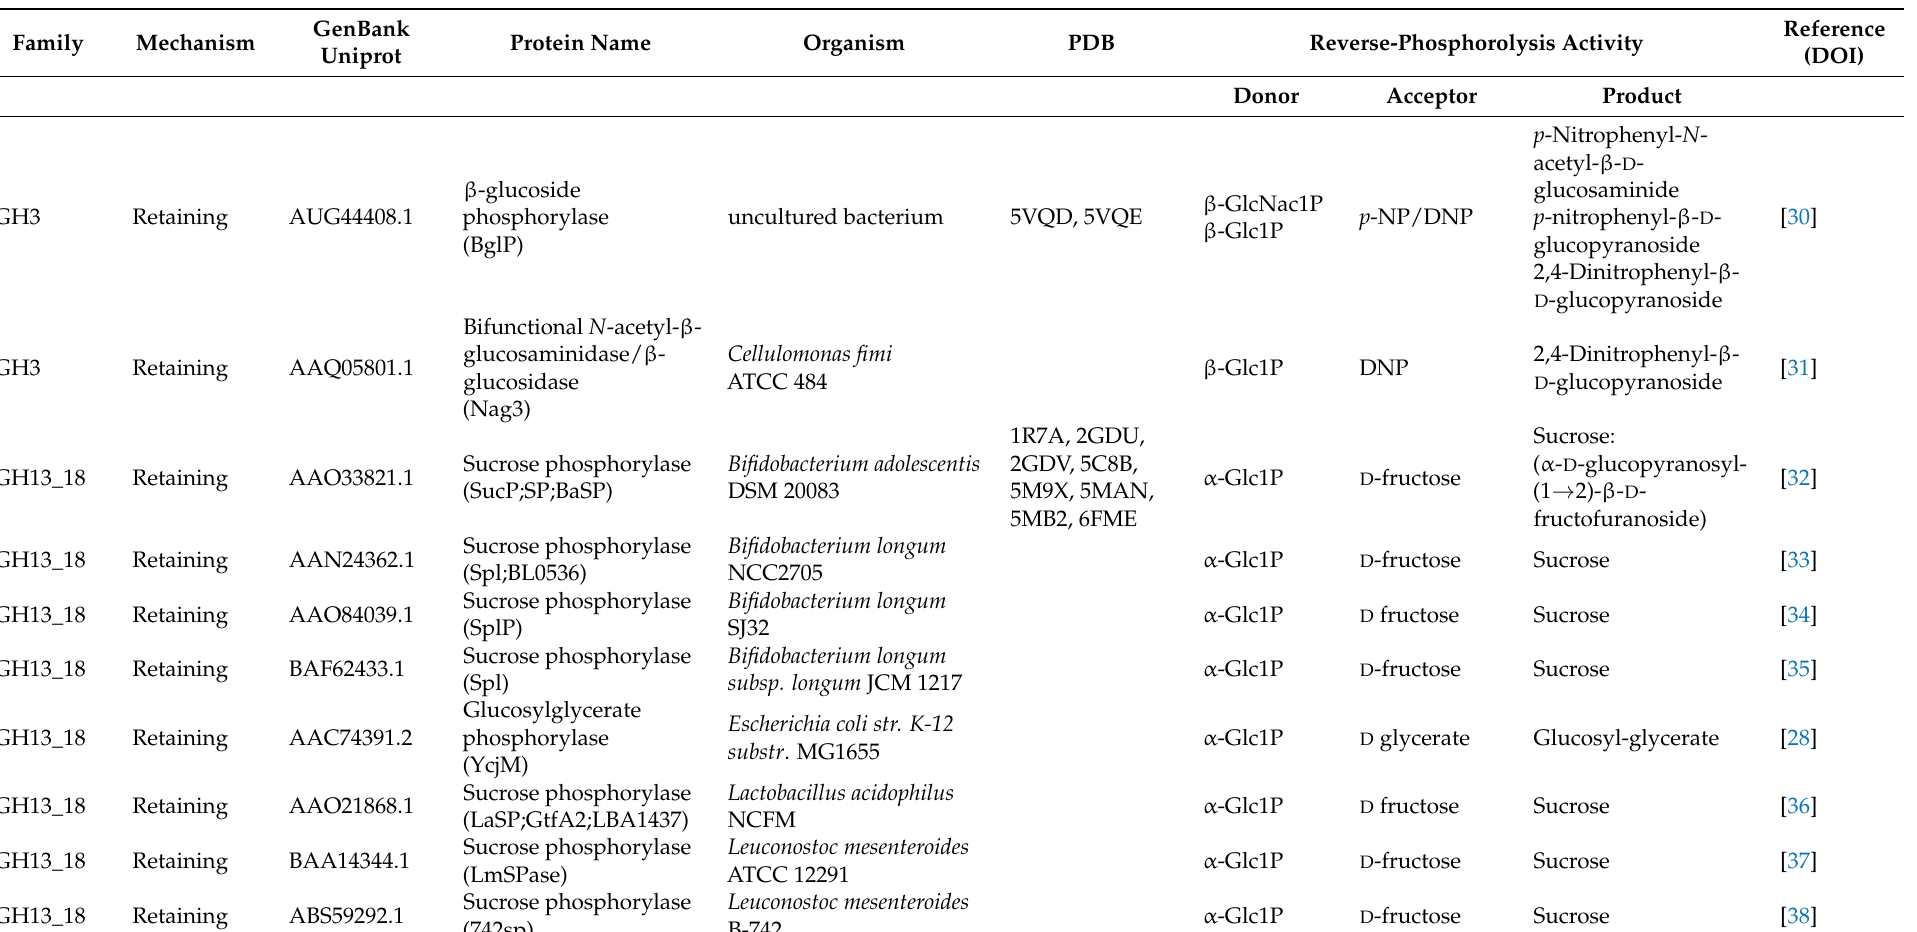
Table 1. List of functionally characterized GPs. Some of the enzymes (labelled with a star) referenced in this table do not currently appear in the list of characterized enzymes of the CAZy